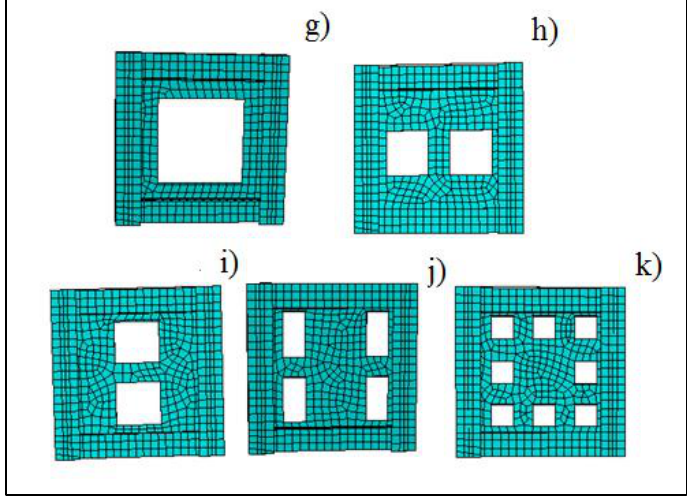
Figure 6. Composite steel shear walls CSSW with different opening location model ( g ) single opening; ( h ) vertical opening; ( i ) horizontal opening; ( j ) four opening; and ( k ) eight opening.